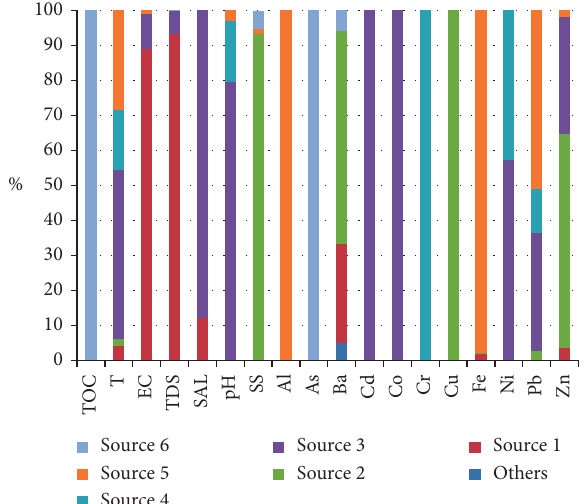
Figure 3: Concentration % for water quality parameters in